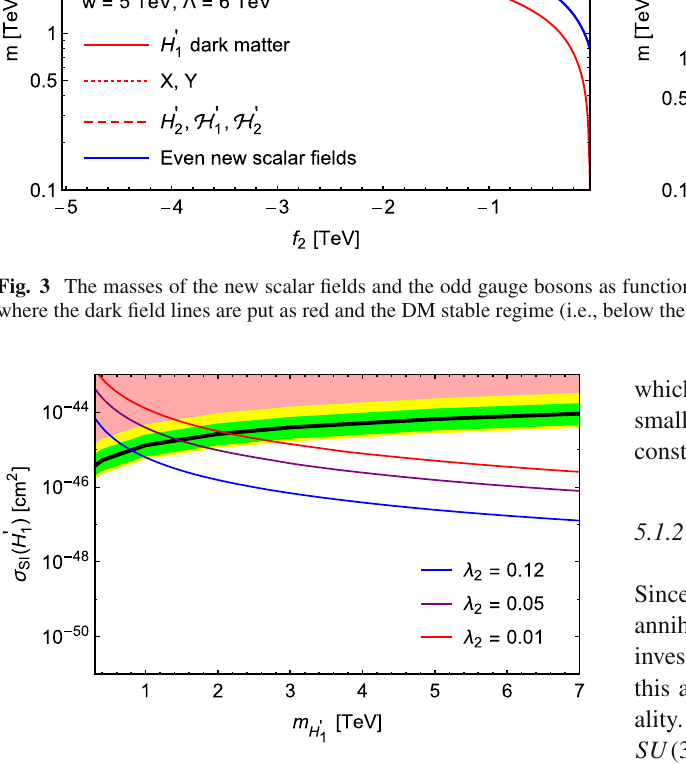
in m , such as w, (cid:11), f 2 and so on, effectively H (cid:10) 1